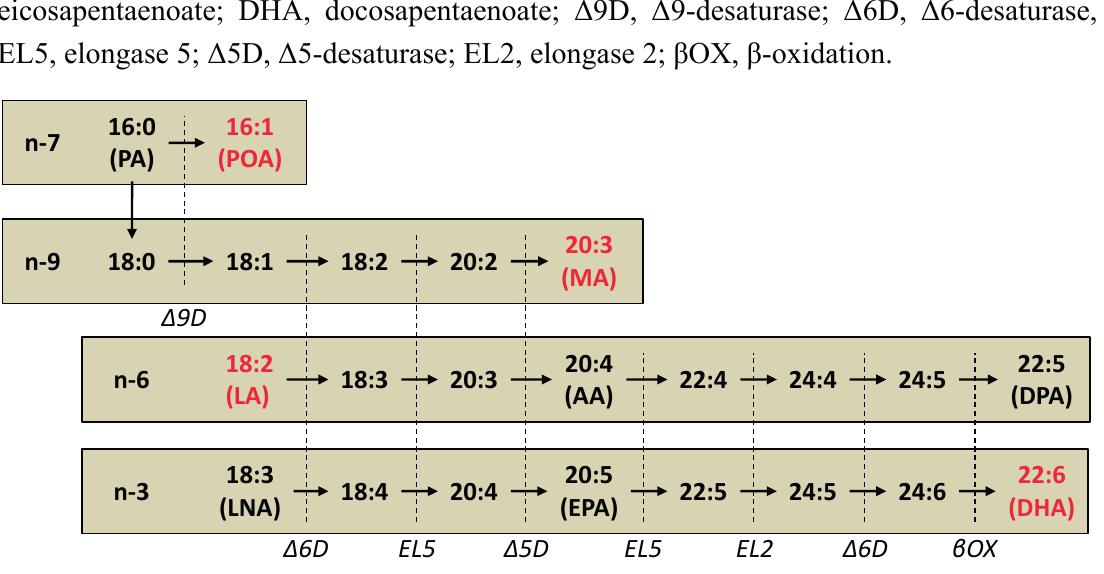
Figure 1. Unsaturated Fatty Acid Metabolism in the n-3, n-6, n-7, and n-9 Pathways. Enzymes are in italics and the vertical dashed line indicates the common reactions that they catalyze. Fatty acids that show consistently abnormal values in blood from cystic fibrosis patients are indicated in red. PA, palmitate; POA, palmitoleate; MA, Mead acid; LA, linoleate; AA, arachidonate; DPA, docosapentaenoate; LNA, alpha-linolenate; EPA, eicosapentaenoate; DHA, docosapentaenoate; Δ 9D, Δ 9-desaturase; Δ 6D, Δ